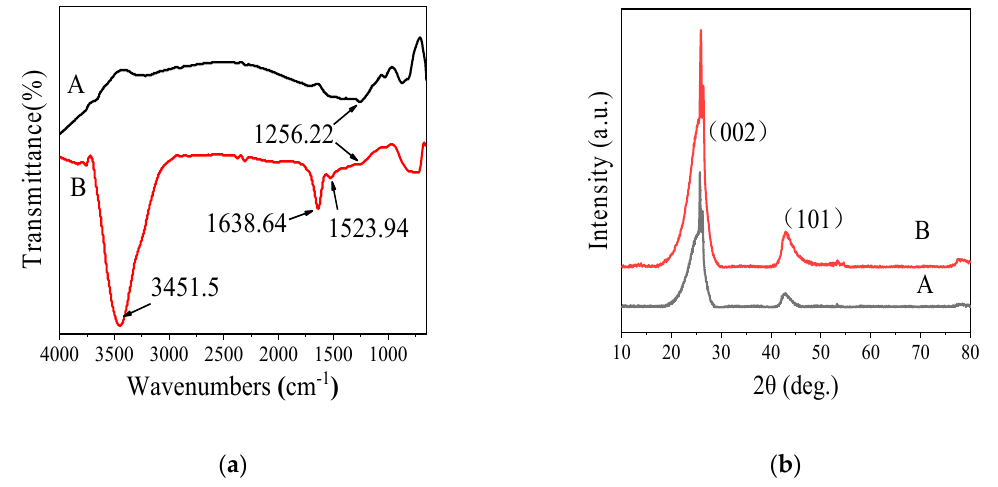
Figure 3. Fourier transform infrared (FT-IR) spectra ( a ) and X-ray diffraction patterns (XRD) ( b ) of MC (A) and MC-COOH (B).